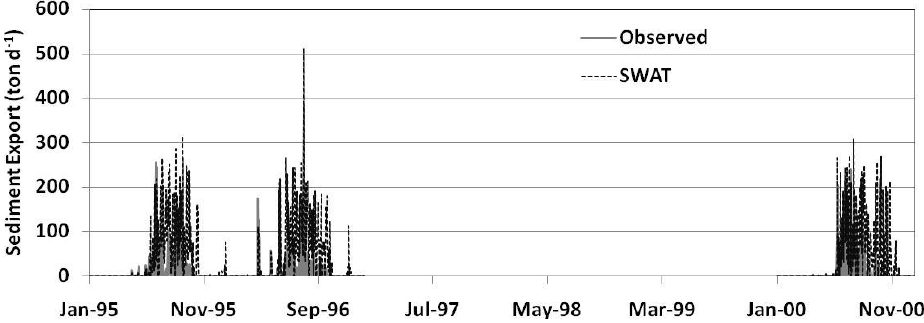
Fig. 11. Measured and SWAT predicted sediment export from the Anjeni micro-watershed.